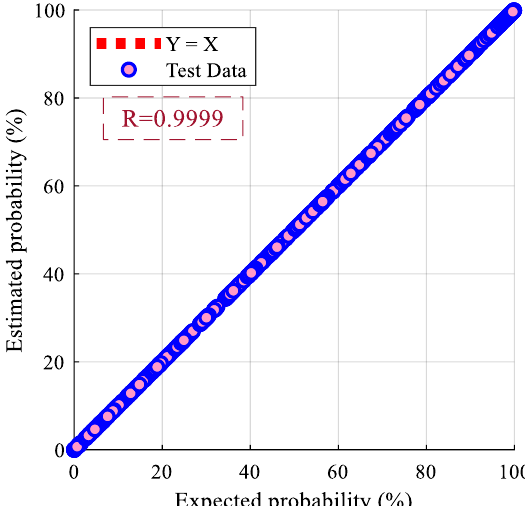
Figure 8. Regression for quench probability estimation by proposed structure of ANN.